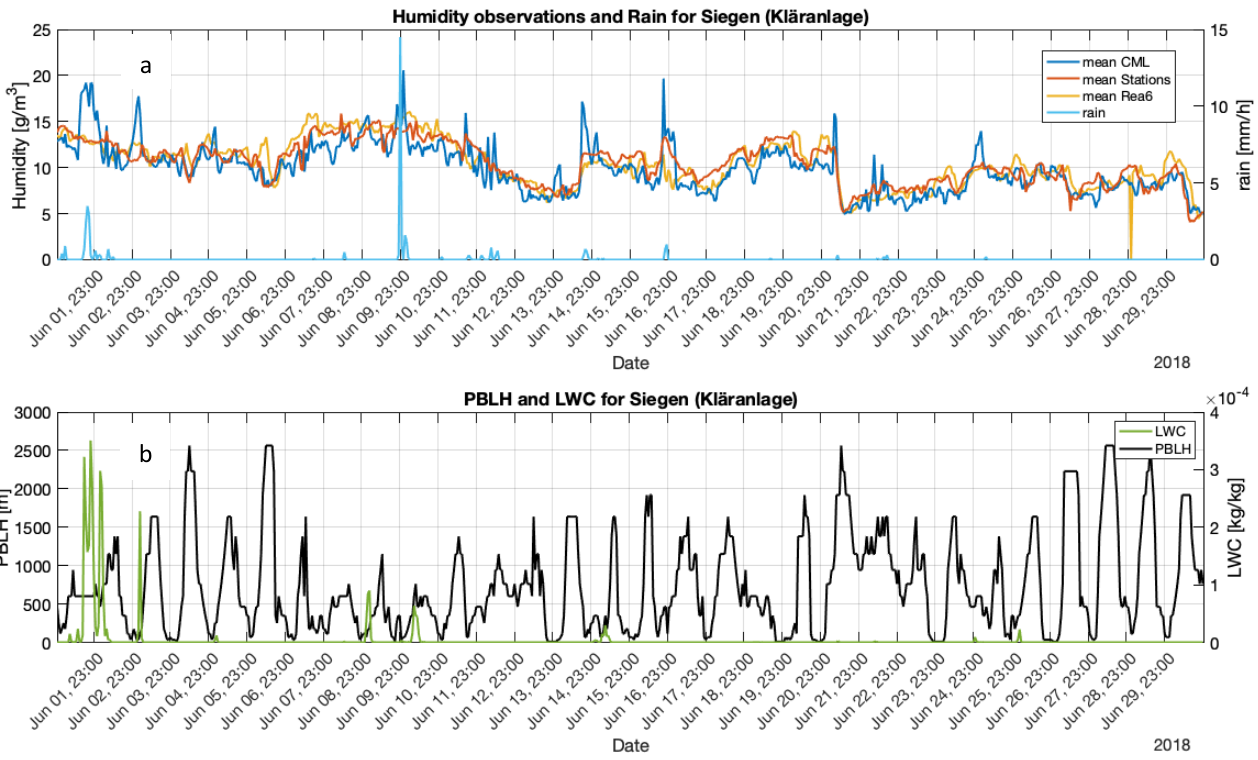
Figure 5. ( a ) Upper panel: hourly humidity observations for June 2018 from CML, stations, and Rea6 (scale on left), as well as hourly precipitation (light blue, rain scale on right in mm/h) at the Siegen station. ( b ) LWC (kg/kg in red) and PBLH (meters, in black) from the ECMWF operational archive and Rea6 (respectively) for June 2018.